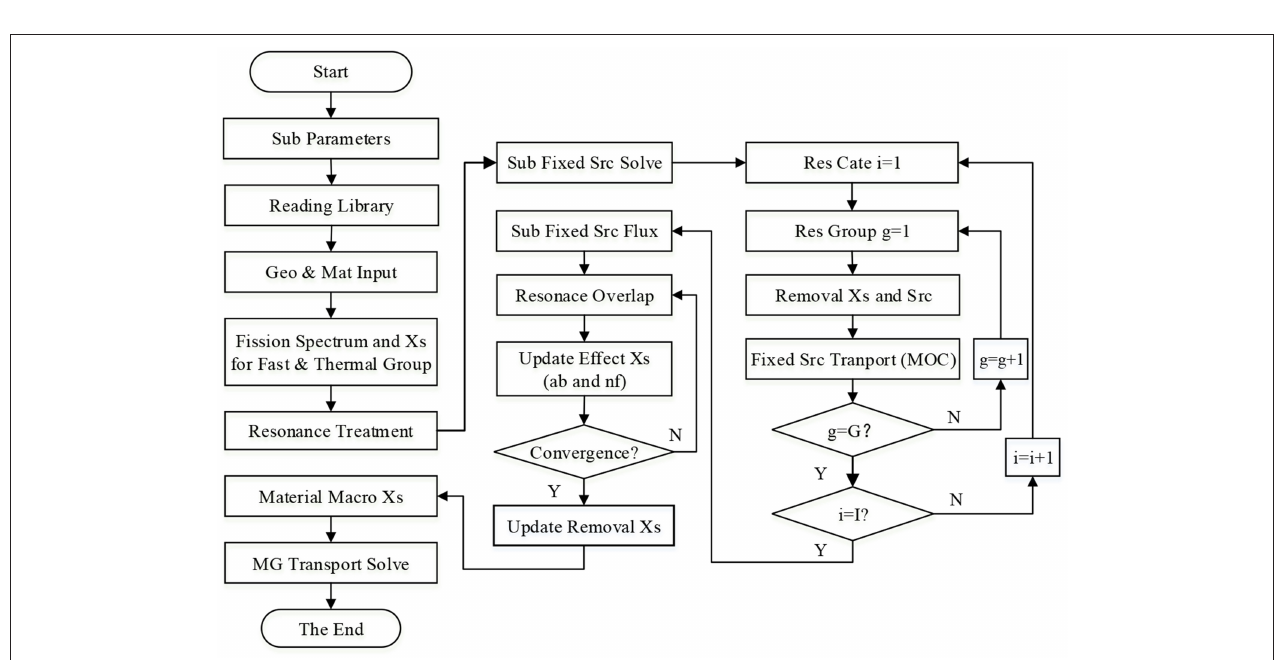
FIGURE 3 | Flow chart of resonance